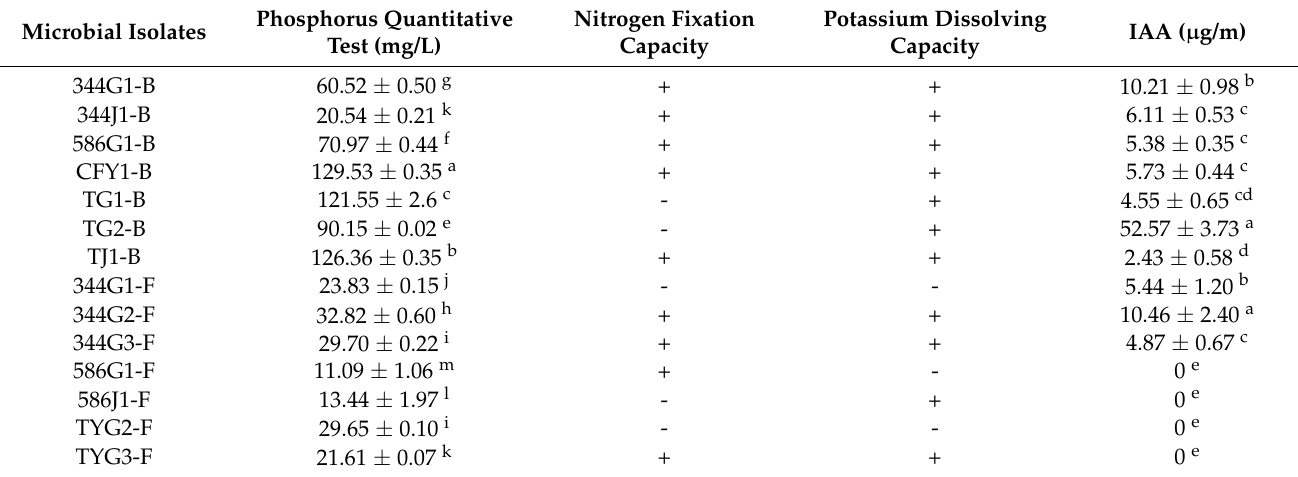
Table 3. Test of phosphorus, potassium, and nitrogen fixation and auxin production ability of endophytic bacteria and